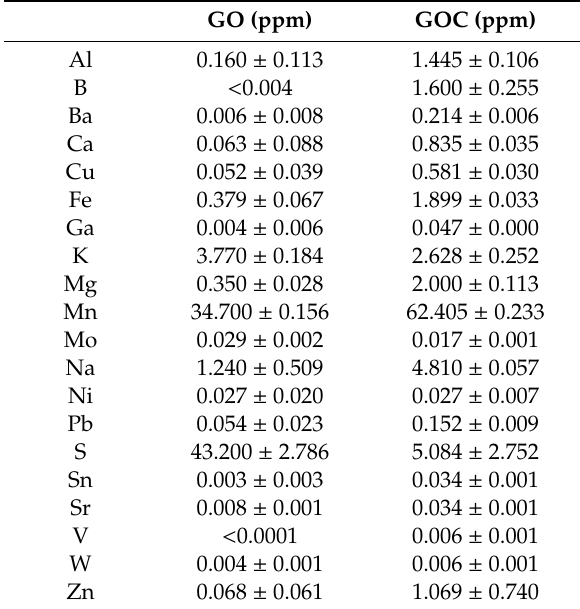
Table 1. Inductively coupled plasma mass spectrometry (ICP-MS) analysis of GO and GOC. Values below the detection limit of the ICP-MS procedure are also